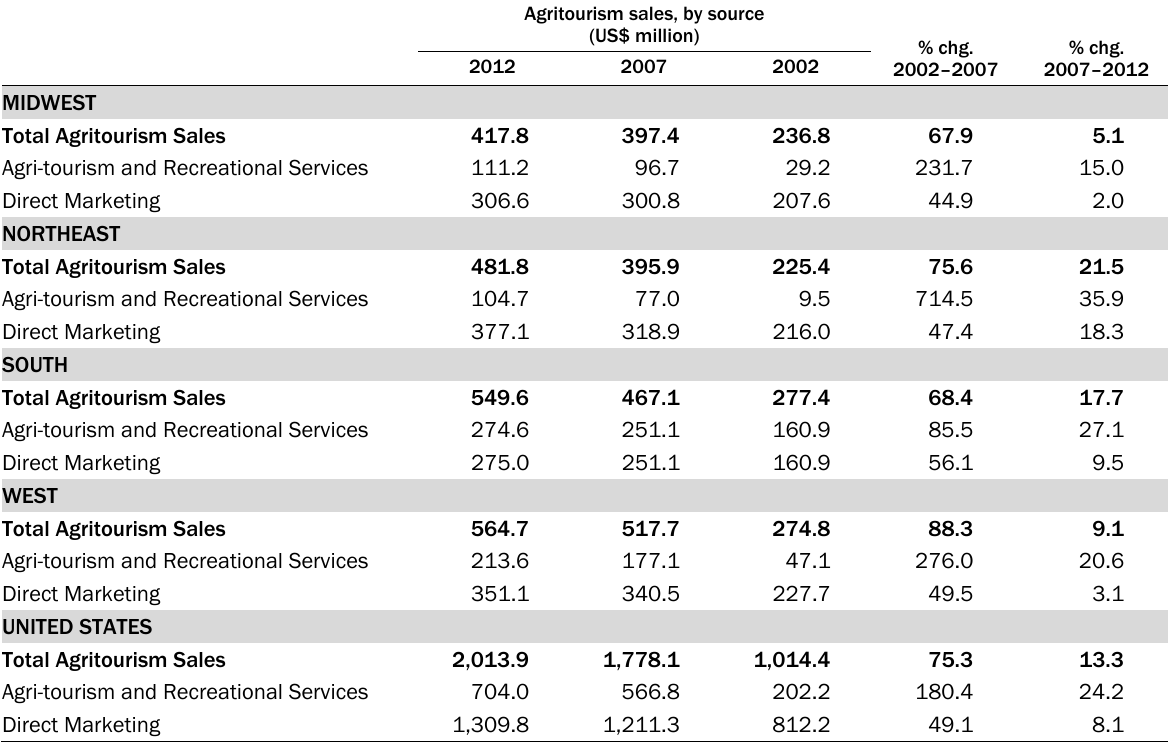
Table 1. Agritourism and Direct Marketing Income Reported in the 2002, 2007, and 2012 Censuses of